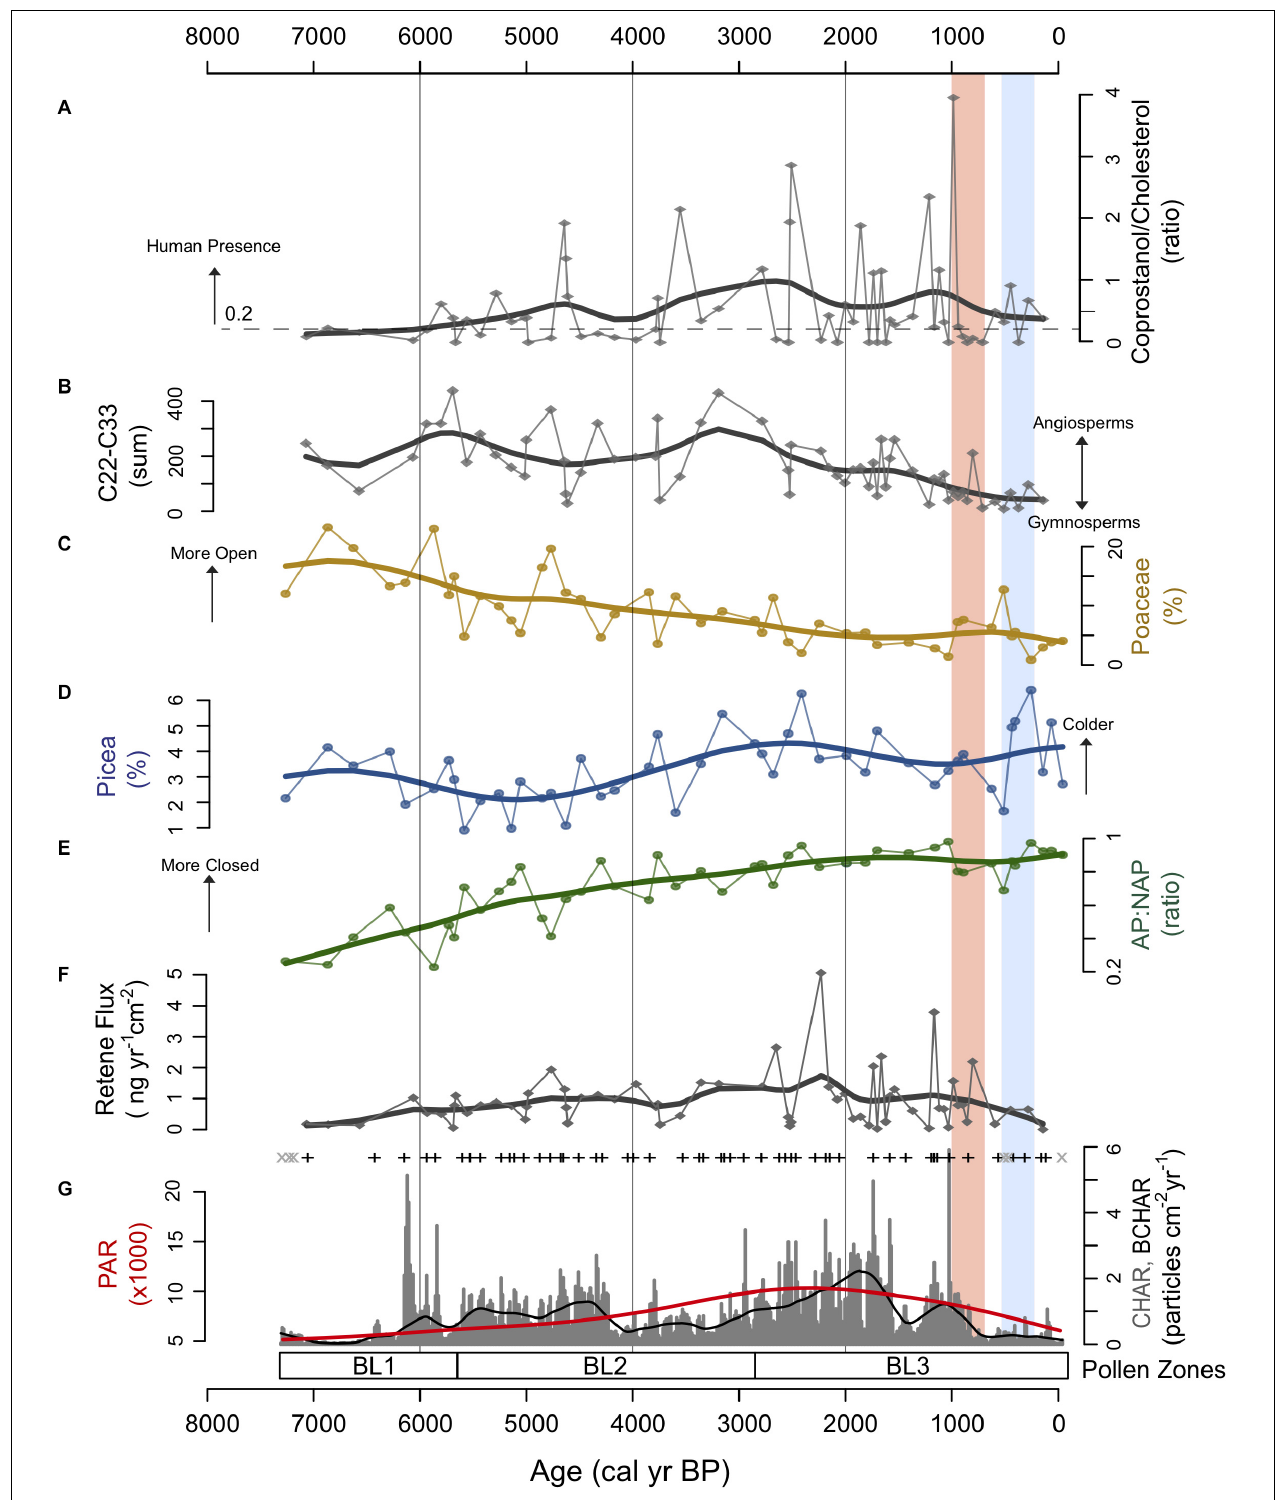
FIGURE 6 | Multi-proxy comparison from Black Lake sediments. (A) Fecal sterol ratio. (B) Total n -alkane sum. (C–E) Pollen percentage data for select taxa and arboreal/non-arboreal pollen ratio (AP:NAP). (F) Retene flux. (G) Charcoal accumulation data and pollen accumulation rate (PAR); gray “x” represent insignificant fire peaks, black “+” represent significant fire peaks, black line represents background charcoal component (BCHAR), red line represents PAR. Red shading represents the Medieval Climate Anomaly (MCA, 1000–750 cal yr BP) and blue shading represents the Little Ice Age (LIA, 550–250 cal yr BP) (Mann et al., 2009).